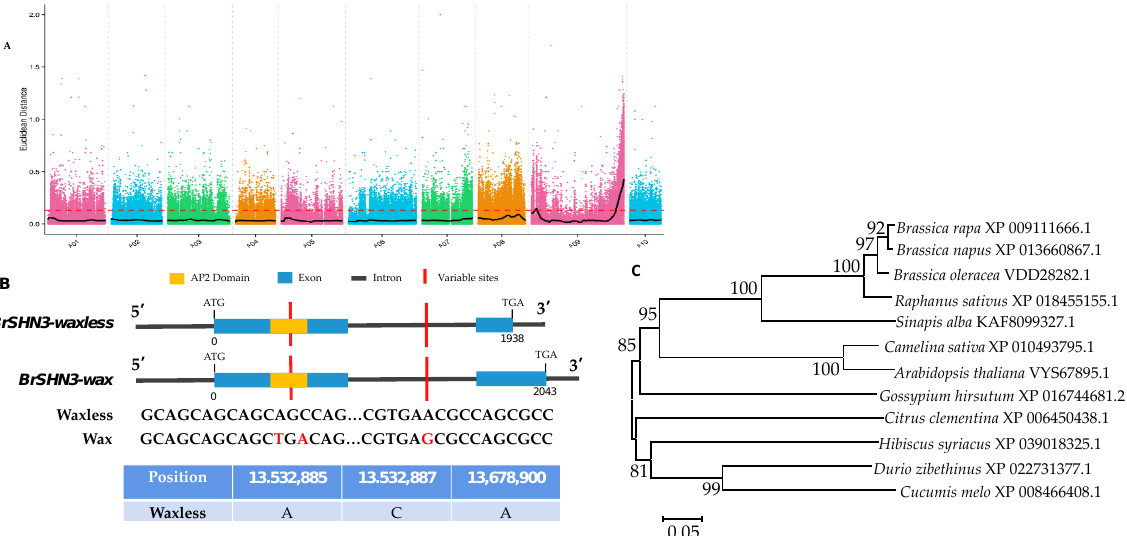
Figure 3. Distribution of ED on chromosomes between interpools ( A ), analysis of waxy candidate gene mutation sites ( B ), and phylogenetic tree of BrSHINE3 of each species ( C